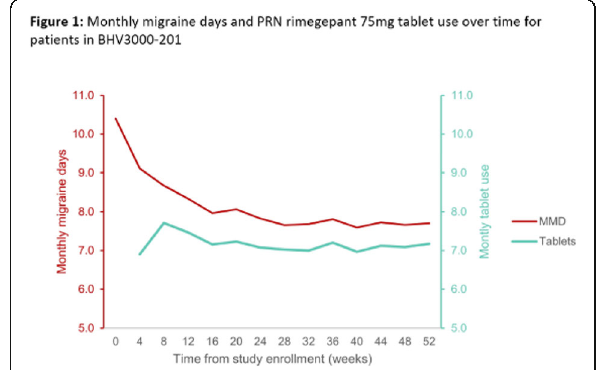
Fig. 1 (abstract P0282). See text for